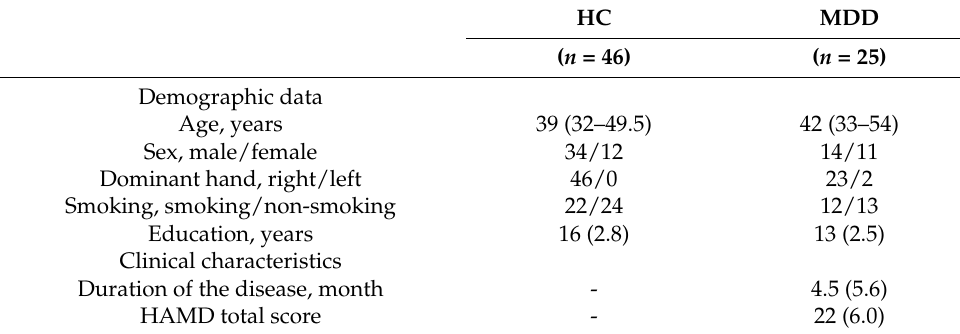
Table 1. Demographic data and clinical